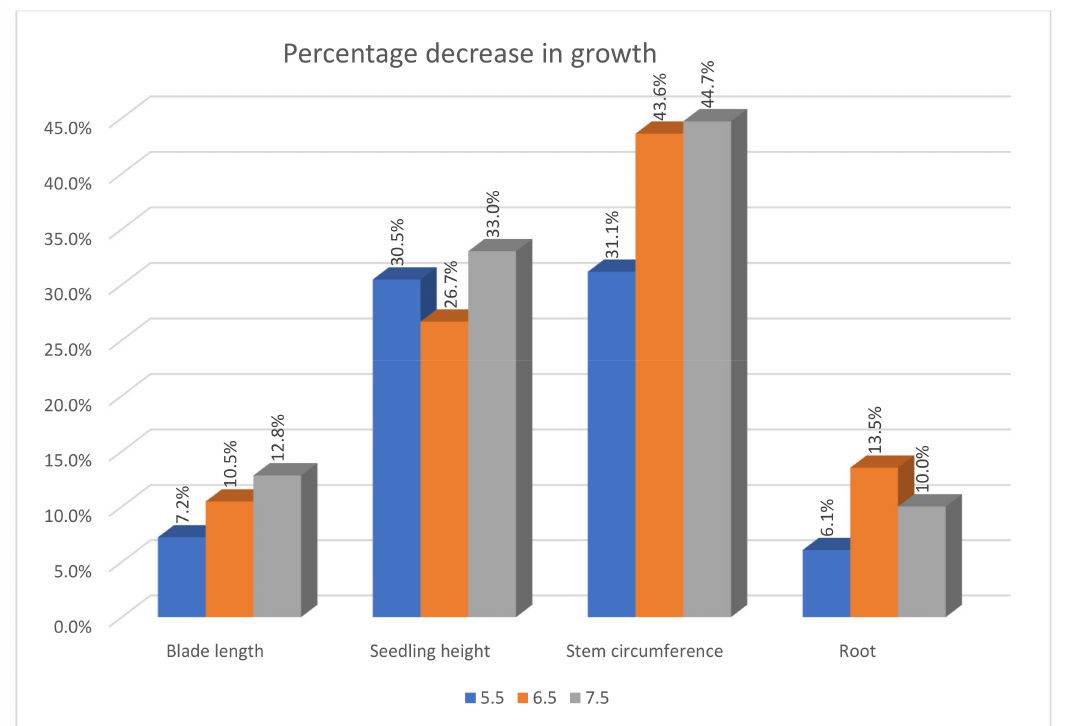
Figure 8. Percentage decrease obtained by comparing the averages of the leaf length, the plant height, the stem circumference, and the root of the seedlings of the double bottom irrigation units U1, U2, and U3 with U10, U11, and U12 respectively. Data collected by the authors.